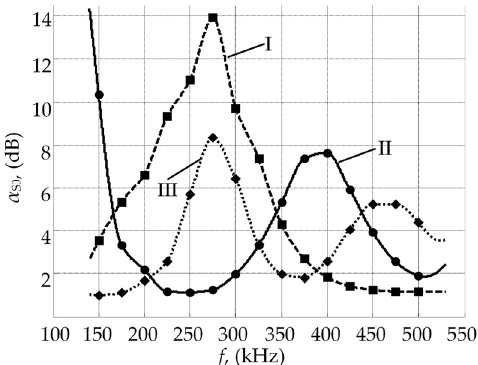
Figure 5. The transmission losses α S0 ( f ) of the S 0 guided wave mode for the different excitation signal frequency in the case of I: 4 mm overlap, II: 9 mm overlap, and III: 13 mm lap joint overlap widths (dots: FE analysis results, solid line: interpolation by piecewise cubic Hermite polynomial).